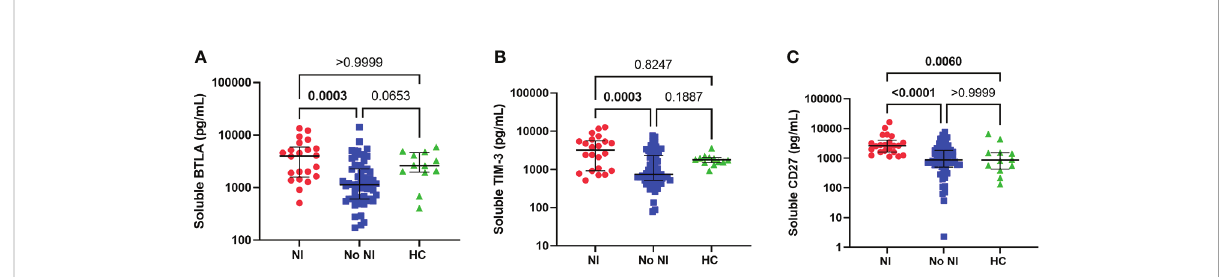
FIGURE 4 Soluble protein in unstimulated plasma within the fi rst 72 hours following pediatric thermal injury. Soluble BTLA (A) , TIM-3 (B) , and CD27 (C) were all signi fi cantly higher in children that went on to develop nosocomial infection (n=22) compared to those patients that did not (n=59) within the fi rst 72 hours after injury. Soluble CD27 (C) was also signi fi cantly higher from healthy controls (n=12). Statistical analysis was performed using one-way ANOVA plus Dunn ’ s test. Lines represent median and interquartile range; dots represent the individual data points. NI, nosocomial infection (red); No NI, no infection (blue); HC, healthy control (n=12).